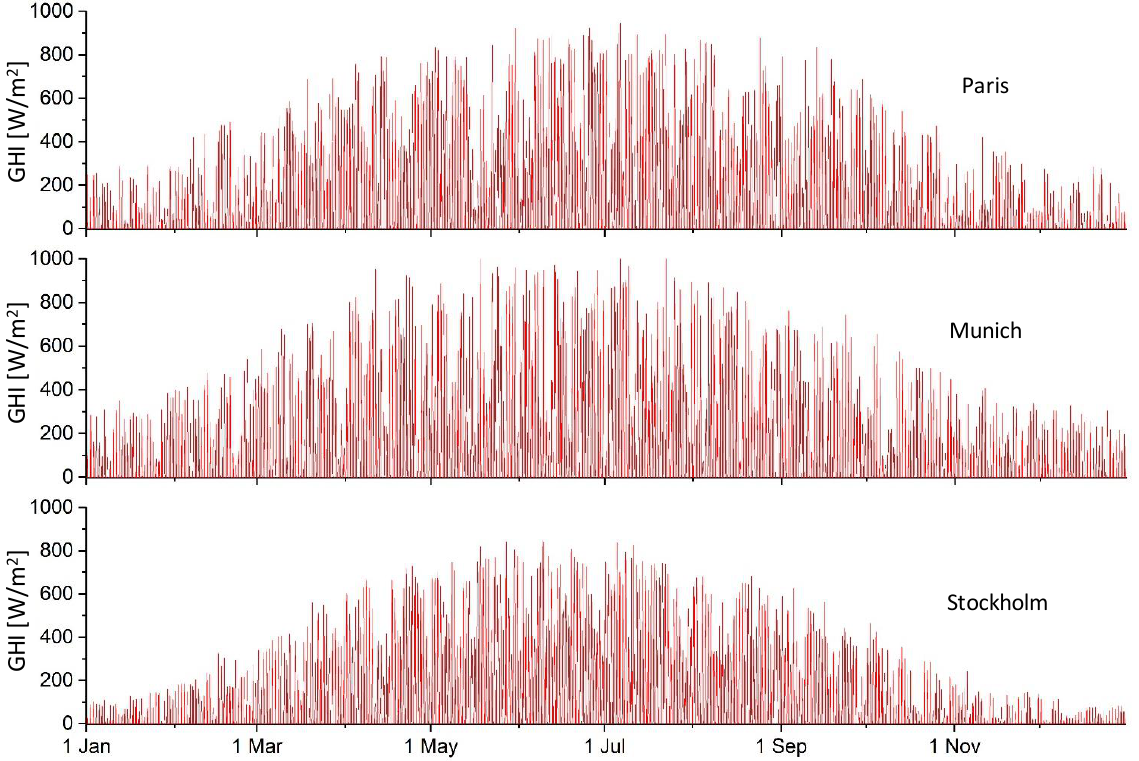
Figure 9. Global horizontal irradiation for the three studied locations.